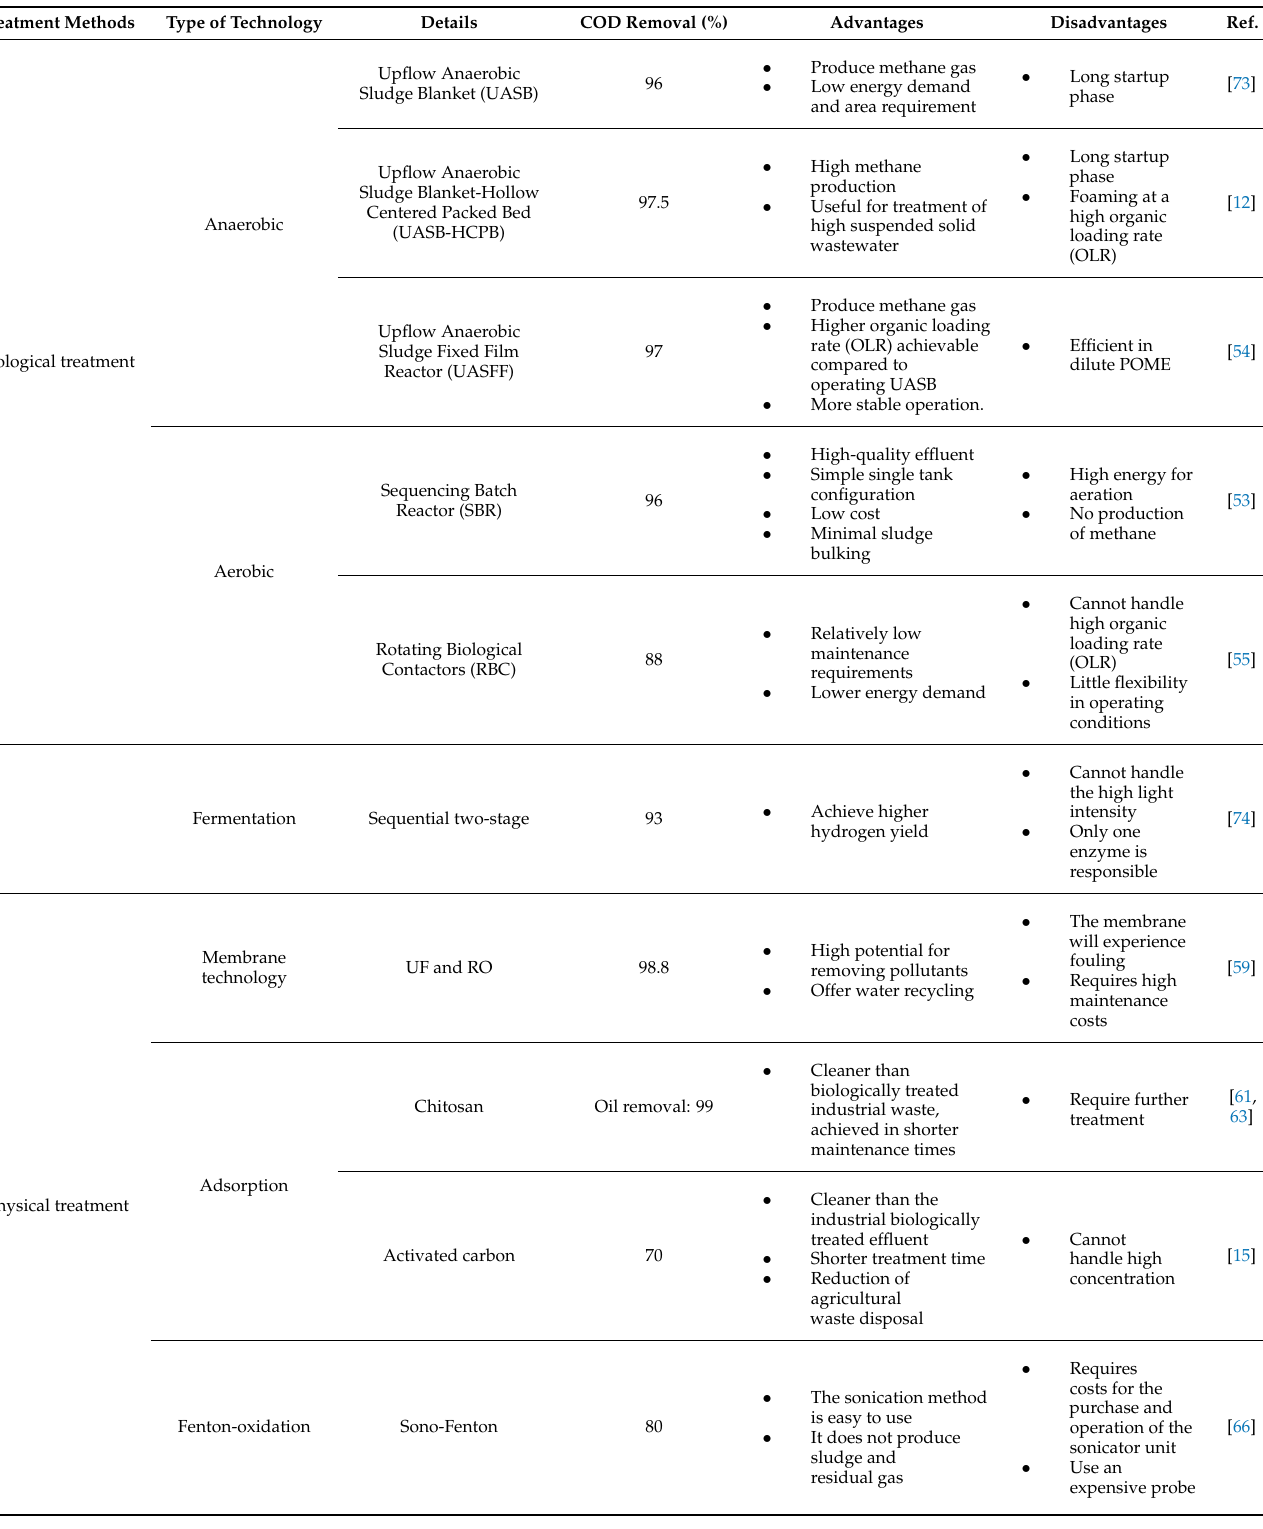
Table 3. Summary of alternative POME treatment methods including COD removal efficiency, advantages, and